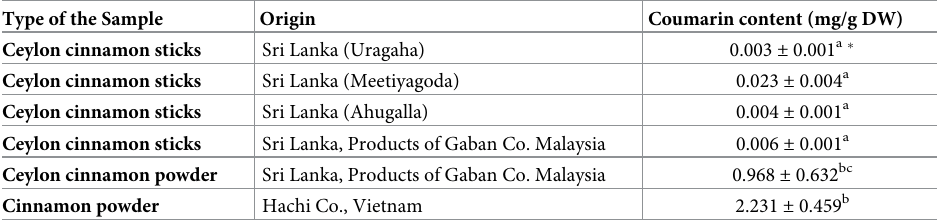
Table 2. Coumarin content of